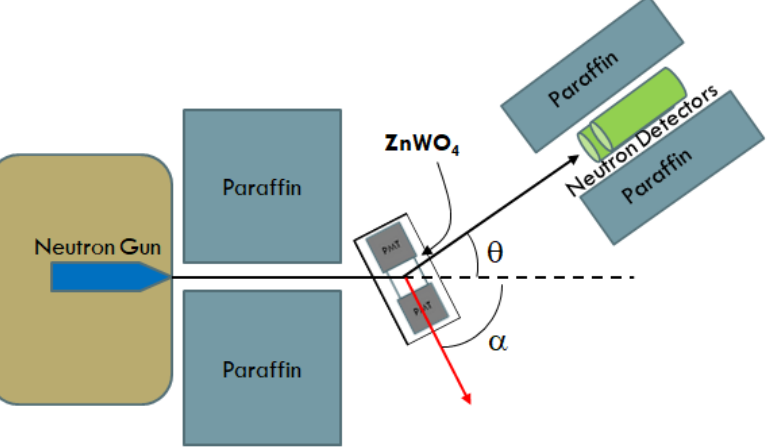
Figure 7. Schematic view from the top of the experimental set-up used at ENEA-Casaccia Laboratory for the measurements of the anisotropic response of the ZnWO 4 detector in the case of nuclear recoils. The two neutron detectors are one above the other. See Ref. [12] for details. Reprinted with permission from [12]. Copyright 2020 Springer